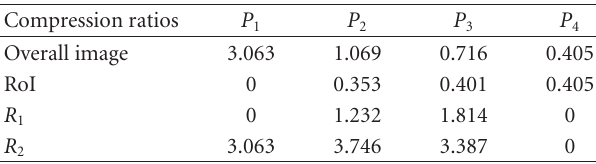
Table 3: The average compression ratio for various regions for the four stages of the progressive image